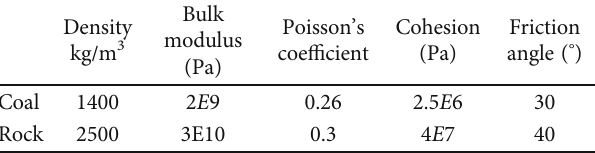
Figure 1: The test result of stressmeters. Table 1: Properties of the coal and rock.